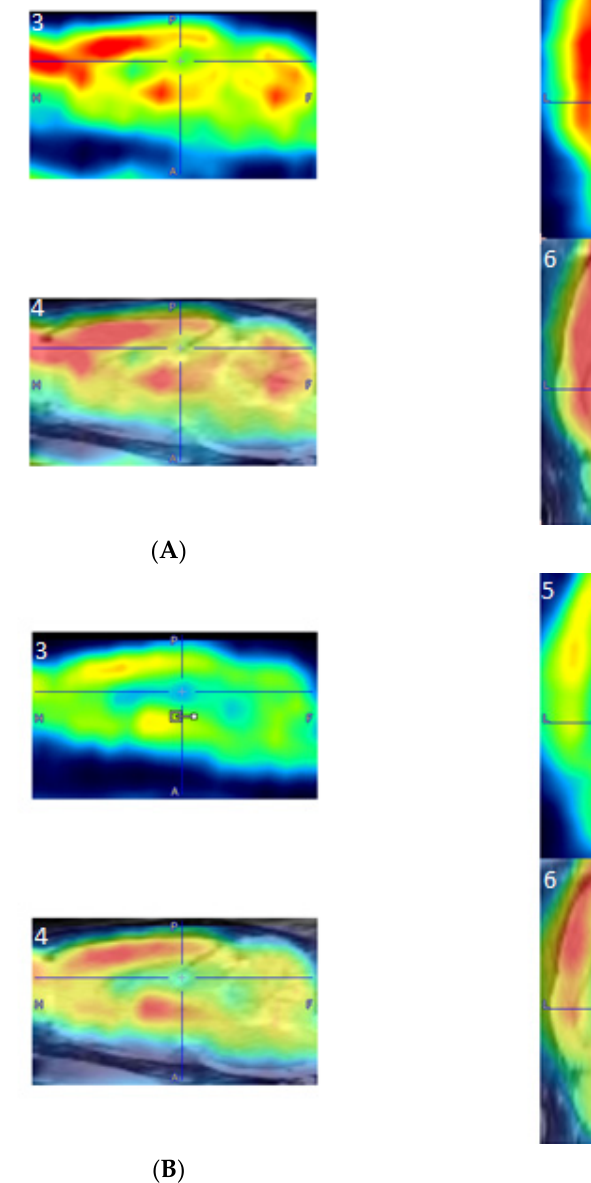
Figure 2. Examples of reconstructed PET images manually co-registered to an fMRI template. ( A ) PET image from an exercised rat: A1, Coronal PET image, exercised rat; A2, coronal co-registered image, exercised rat; A3, sagittal PET image, exercised rat; A4, sagittal co-registered image, exercised rat; A5, horizontal PET image, exercised rat; and A6, horizontal co-registered image, exercised rat. ( B ) PET images from a sedentary rat: B1, coronal PET image, sedentary rat; B2, coronal co-registered image, sedentary rat; B3, sagittal PET image, sedentary rat; B4, sagittal co-registered image, sedentary rat; B5, horizontal PET image, sedentary rat; and B6, horizontal co-registered image, sedentary